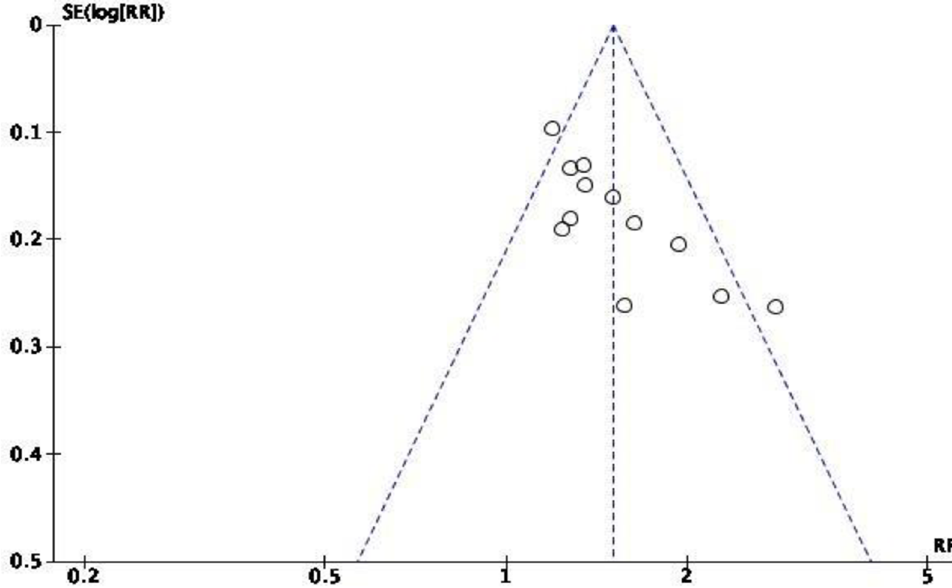
Fig 2. Funnel plot of studies comparing fire acupuncture after stroke in